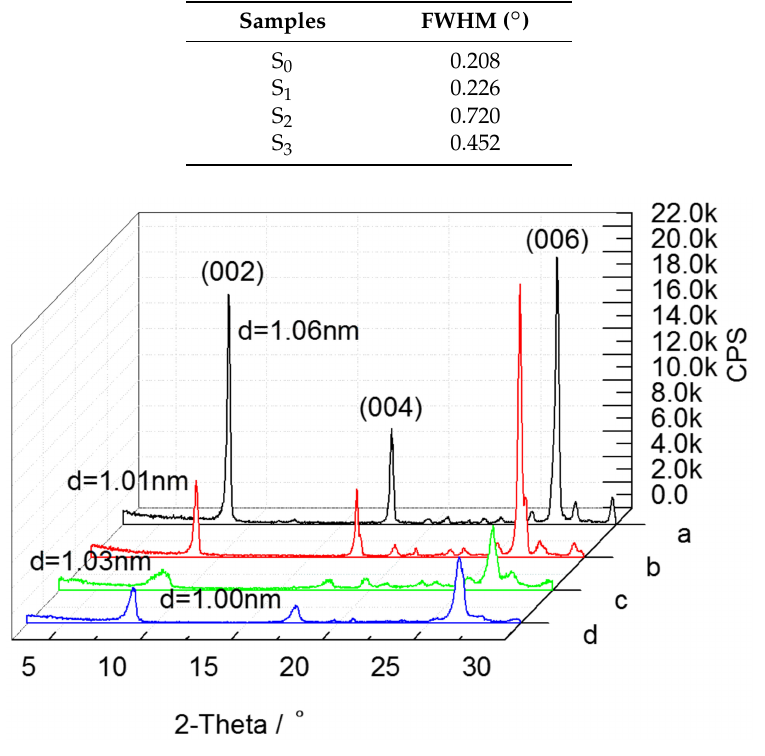
Figure 8. XRD patterns of ( a ) S 0 ; ( b ) S 1 ; ( c ) S 2 ; and ( d ) S 3 .